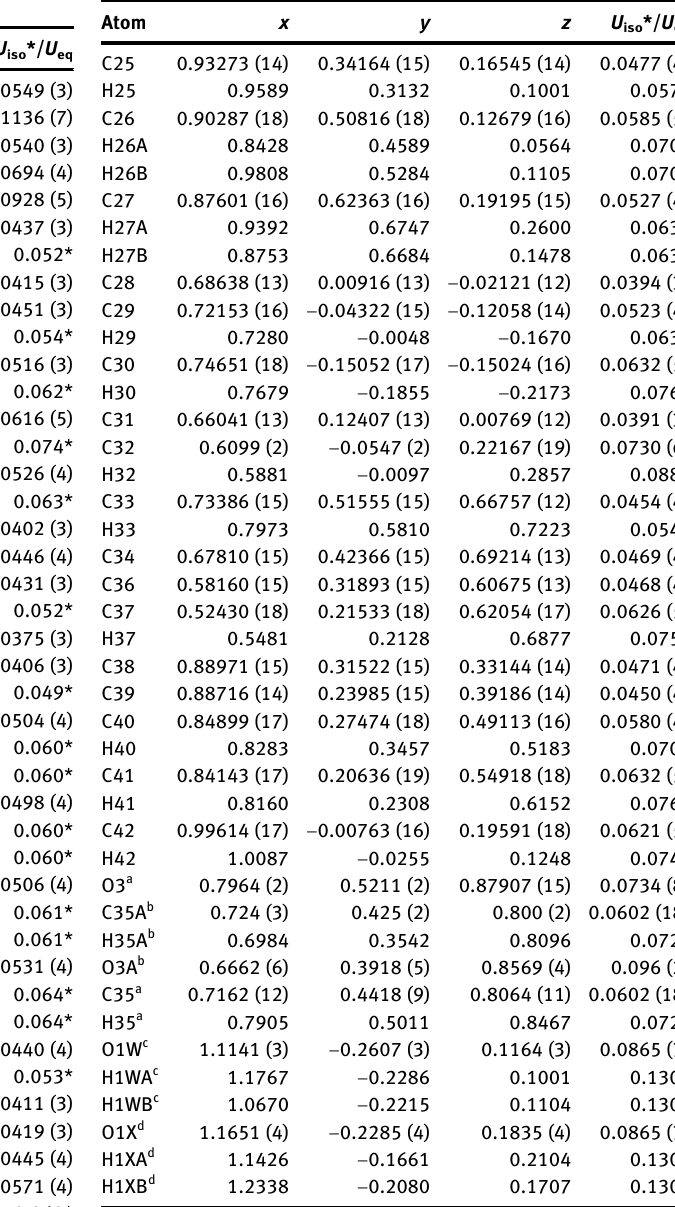
Table  : Fractional atomic coordinates and isotropic or equivalent isotropic displacement parameters (Å 